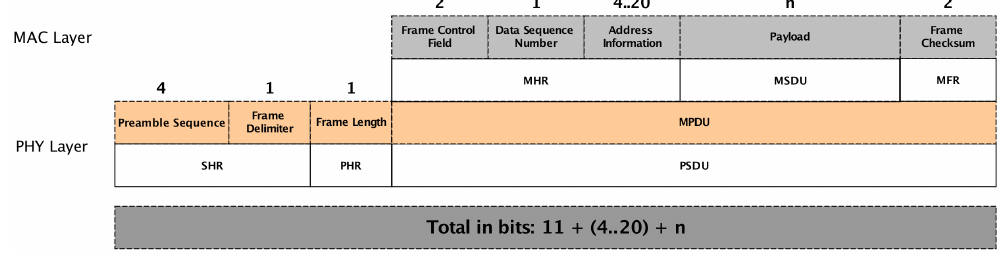
Figure 9. 802.15.4 Data